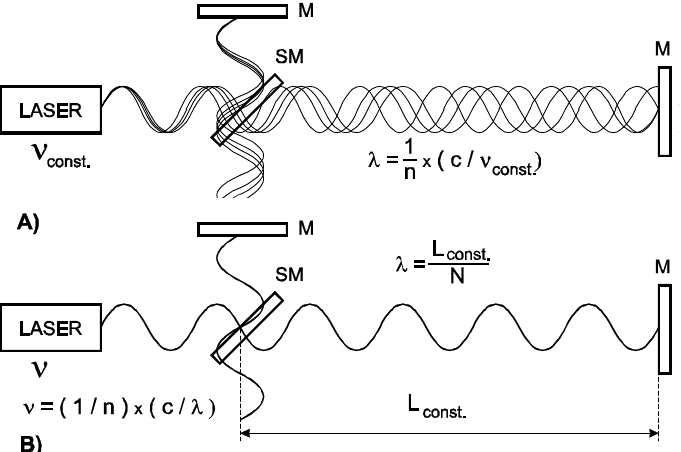
Figure 1. Varying wavelength in Michelson interferometer with laser with stabilized optical frequency ( A ) and interferometer with stabilized wavelength ( B ) M: mirror, S: semireflecting mirror, N: fixed number of